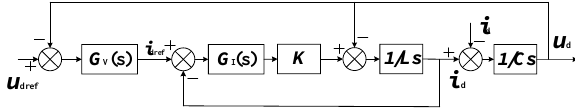
Figure 12. Block diagram of double closed-loop control.